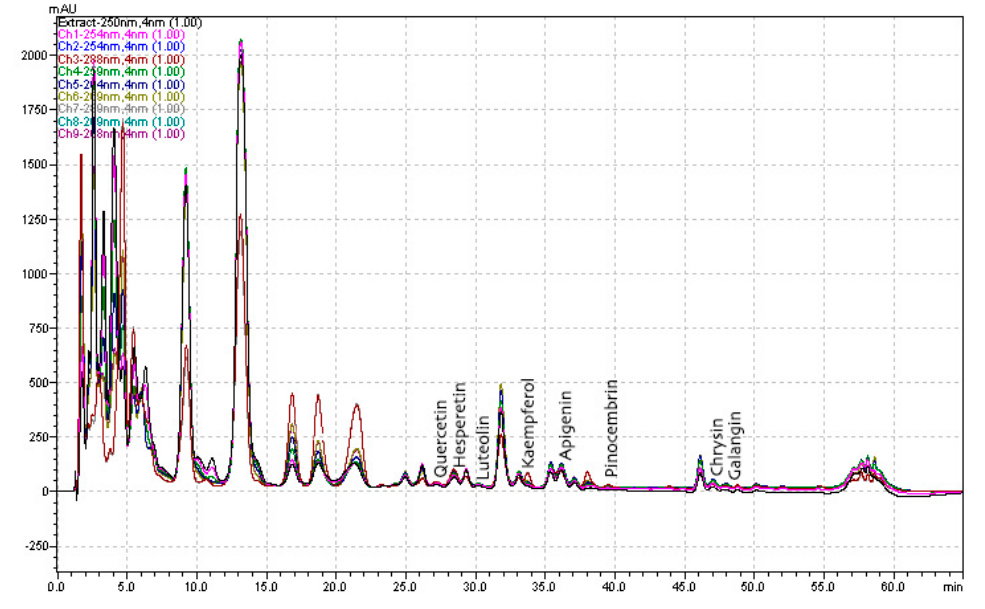
Figure 2. A typical chromatogram of multifloral honey.